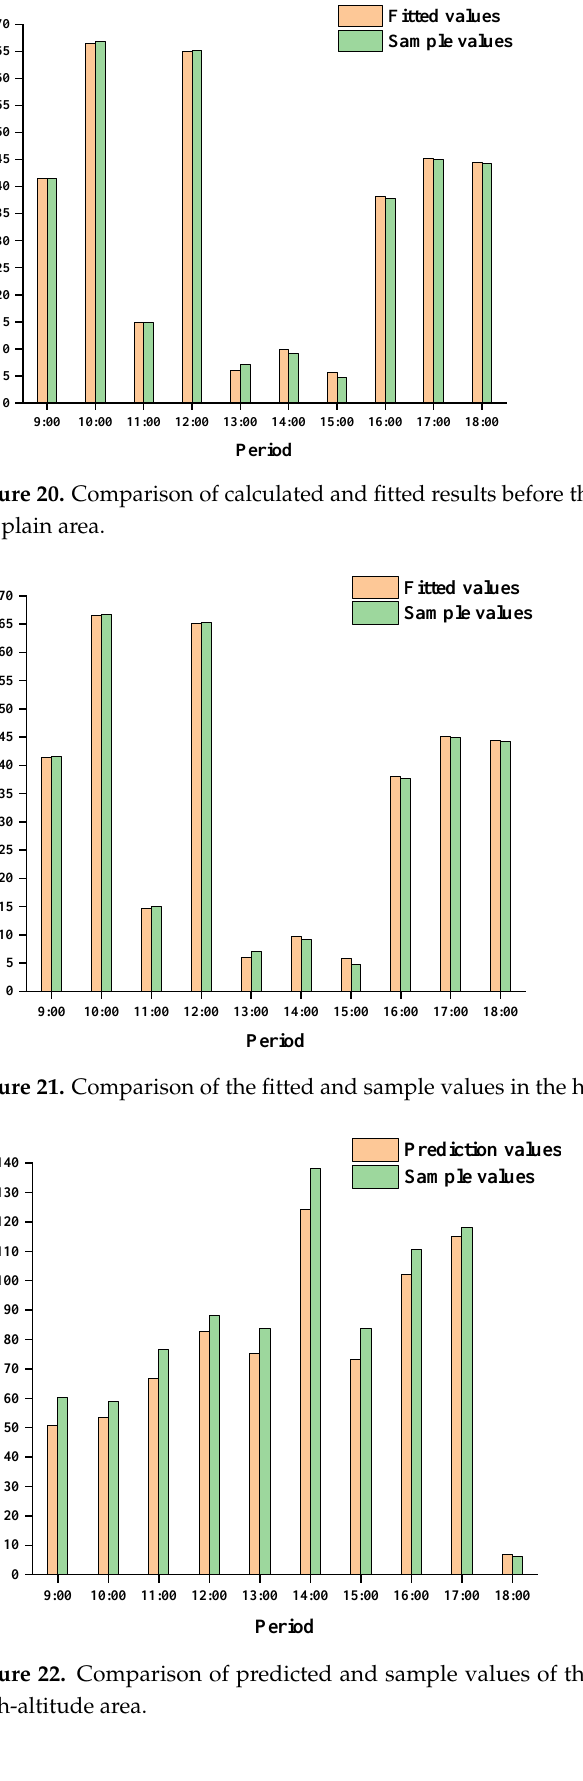
Figure 22. Comparison of predicted and sample values of the greenhouse ventilation rate in the high-altitude area.